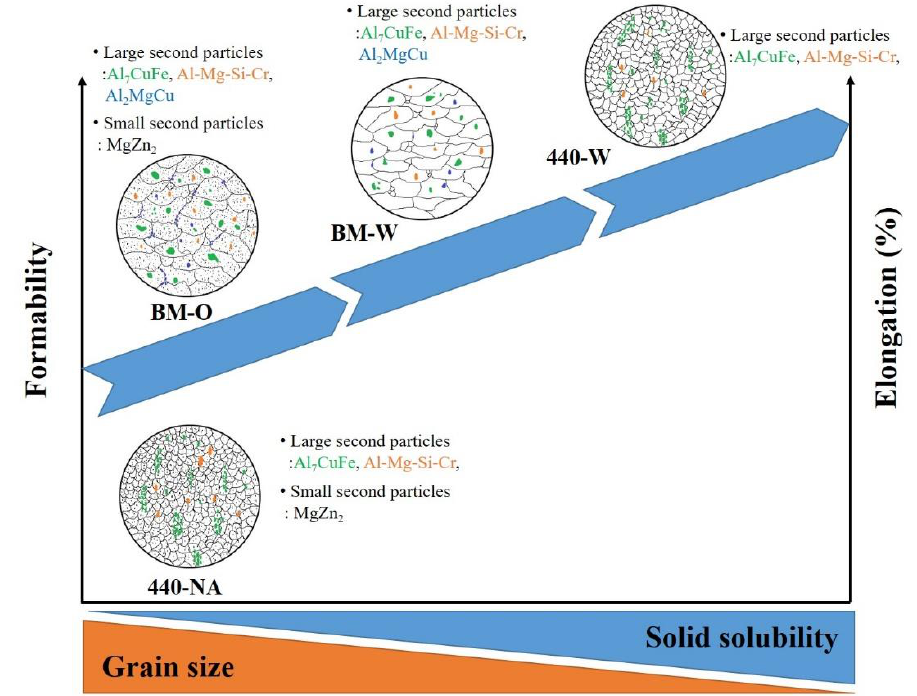
Figure 10. A schematic diagram of the relationships among formability, elongation, and microstructure for 7075 aluminum alloys after FSP and various heat treatments.